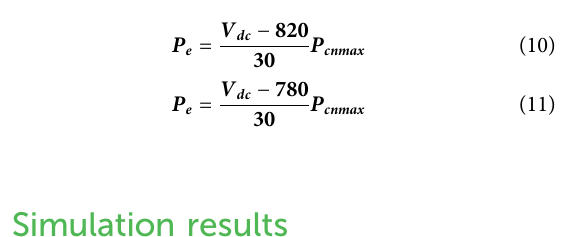
Figure 8B. The main parameters of BESS are as follows: the maximum capacity is 25 kW h, the maximum power is 7.5 kW, the maximum value of the SOC is 0.9, and the minimum value is 0.2. In Figure 8C, the green line represents the total electricity cost without BESS, the black line represents the total electricity cost without optimization, and the red line represents the total electricity cost after optimization. It can be seen from the fi gure that the FSOP and its operation strategy proposed in this paper reduce the power consumption cost of the system by about 6%